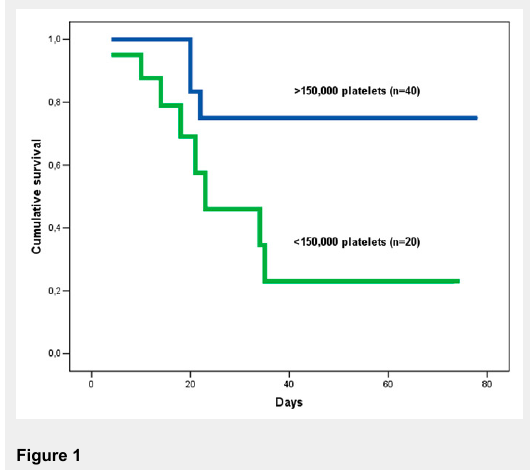
Cumulative survival rate of H1N1 influenza respiratory failure patients with